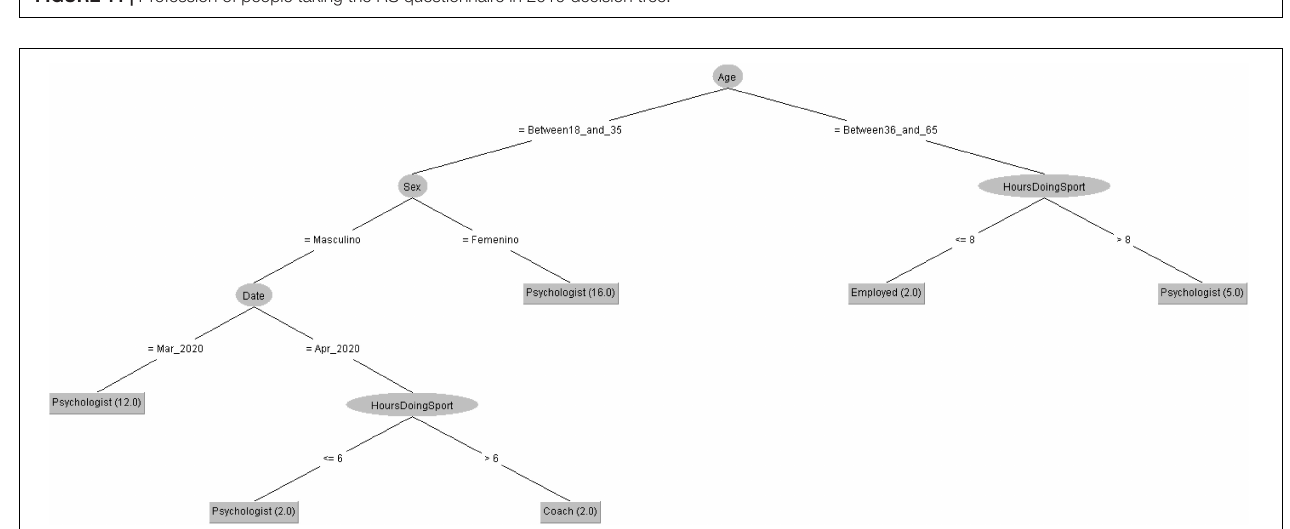
FIGURE 12 | Profession of people taking the RS questionnaire in 2020 decision tree.